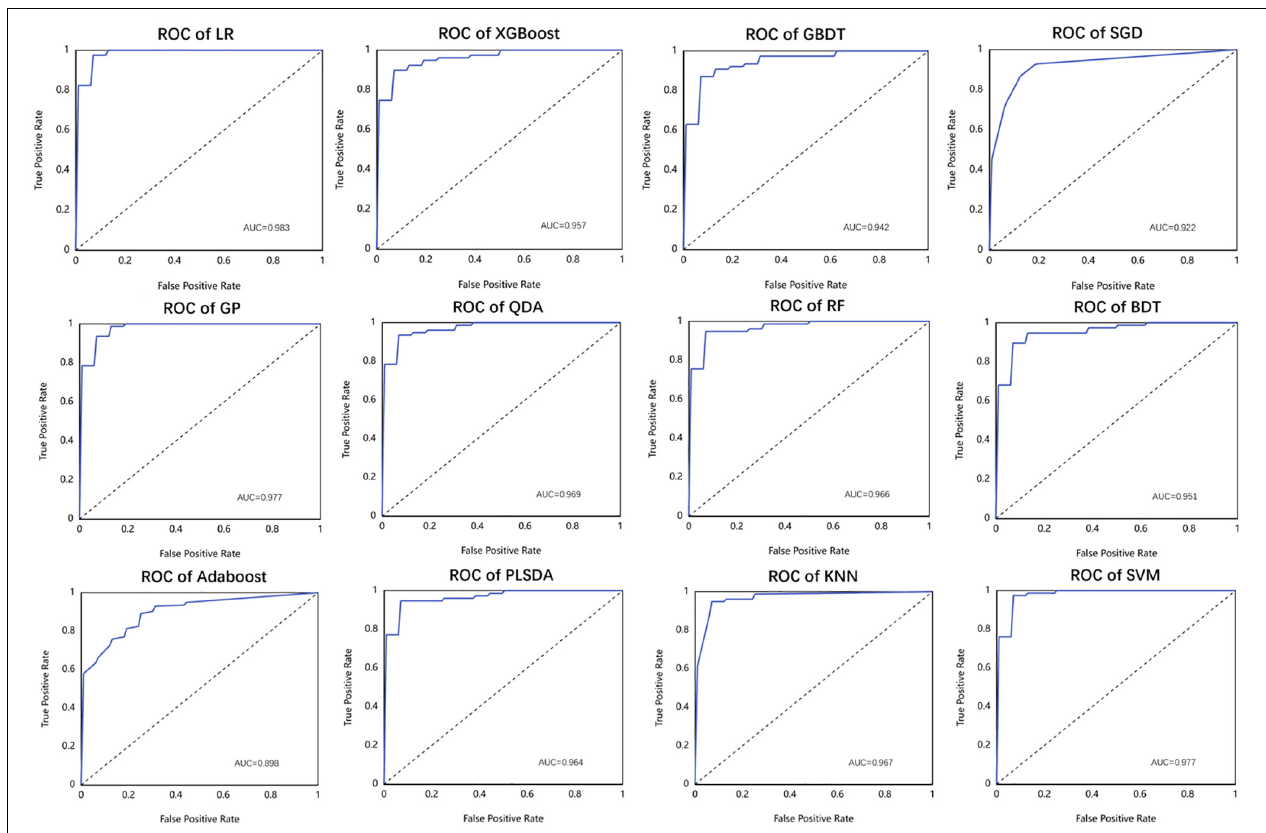
FIGURE 7 | The performance of different machine learning models used in this study in the form of receiver operator curve